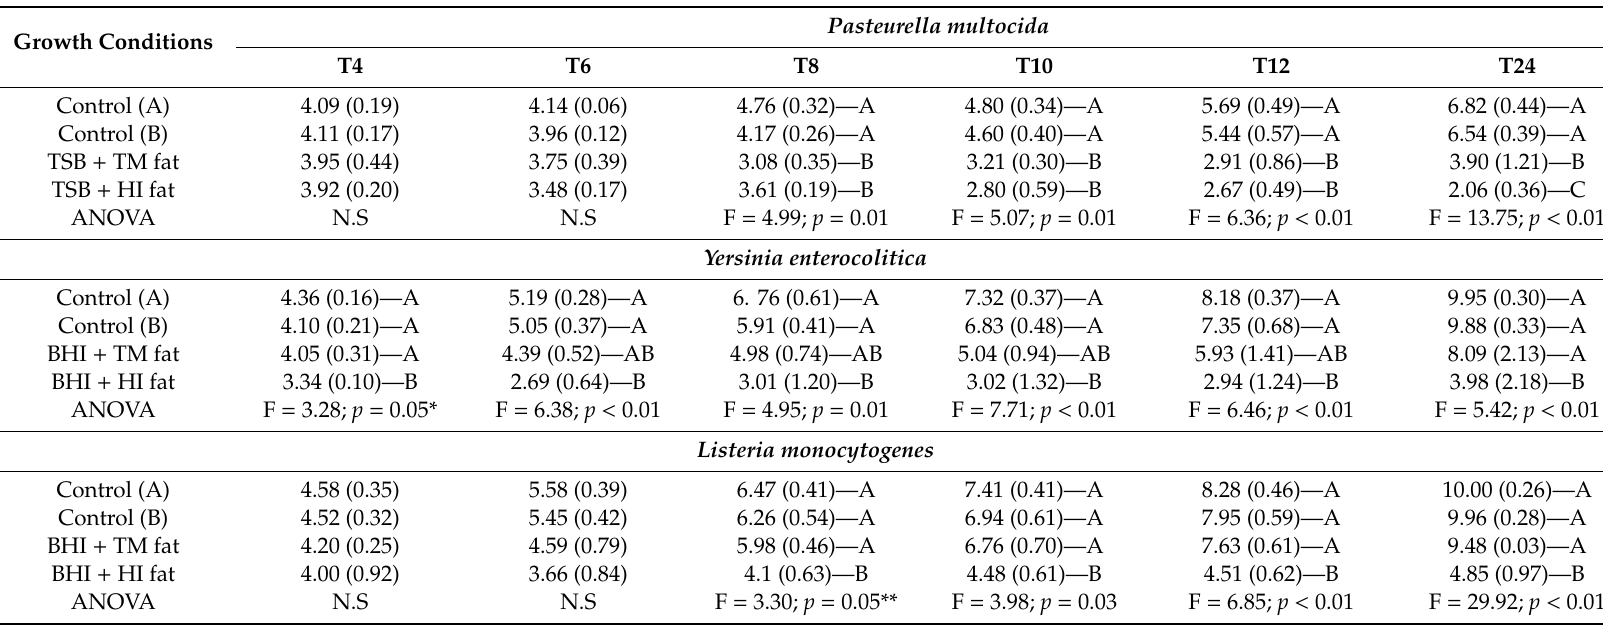
Table 3. Distribution of average cell counts (Log (CFU) / per mL) over time for the three bacterial species for which inhibition was recorded (means ± SEM; n = 3). Growth